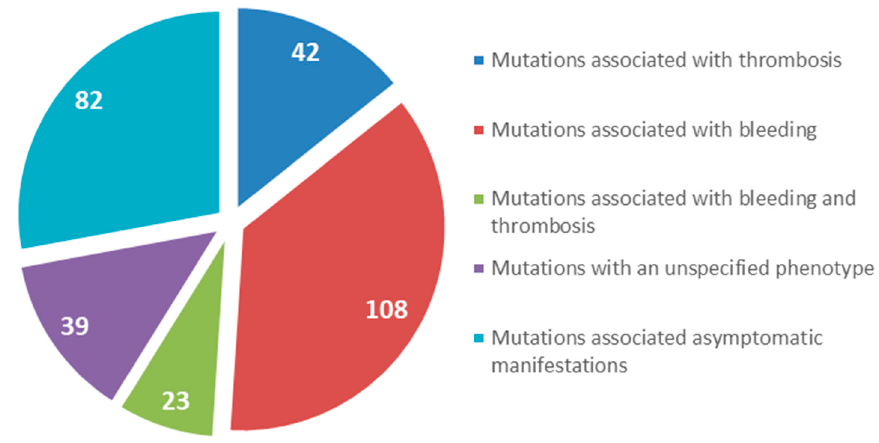
Figure 2. Total number of mutations located in the beta and gamma nodules in the fibrinogen molecule (B β and γ chains).